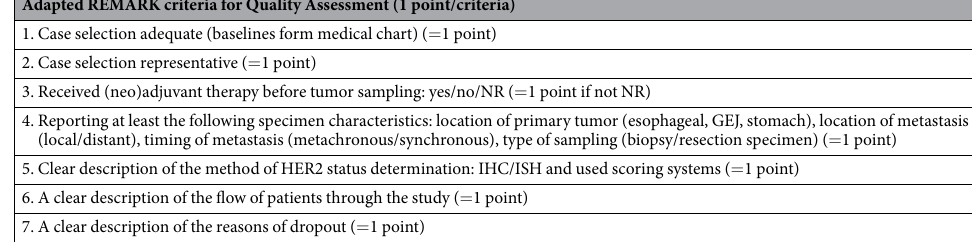
Table 1. Adapted REMARK criteria for Quality Assessment 39 . Studies are appointed one point for each item, half a point is allocated in case of ambiguity.